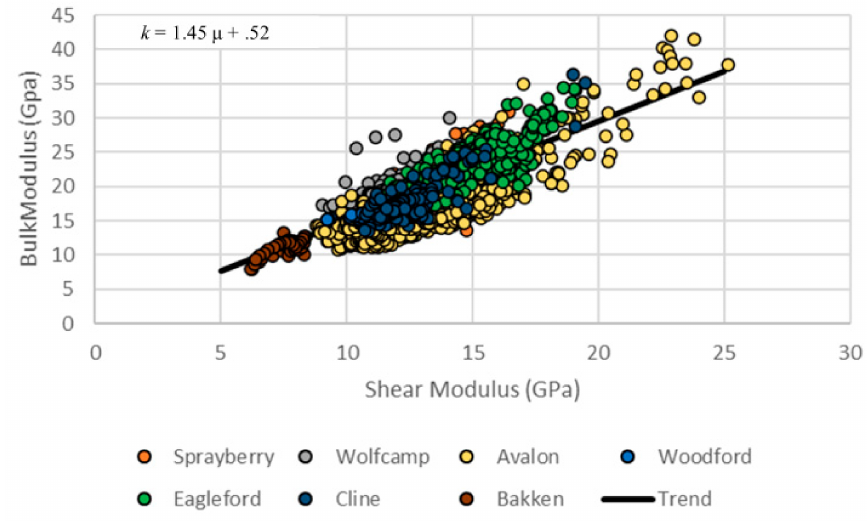
Figure 4. Overall bulk modulus ( k ) versus shear modulus ( µ ) trend for well log measurements from all reservoirs studied. V p , V s , and ρ logs were used to calculate dynamic moduli using Equations (1)–(3). As there are over 2000 closely spaced datapoints following the predominant trend, the points primarily overlay. The di ff erence in behavior for di ff erent formations is better seen in Figure 5. The least-mean-square regression fit for all formations combined is k = 1.45 u + 0.52 for moduli in GPa. The correlation coe ffi cient is 0.78, the F-test is over 3000, sig F is zero, and the standard error is 2.79 GPa.